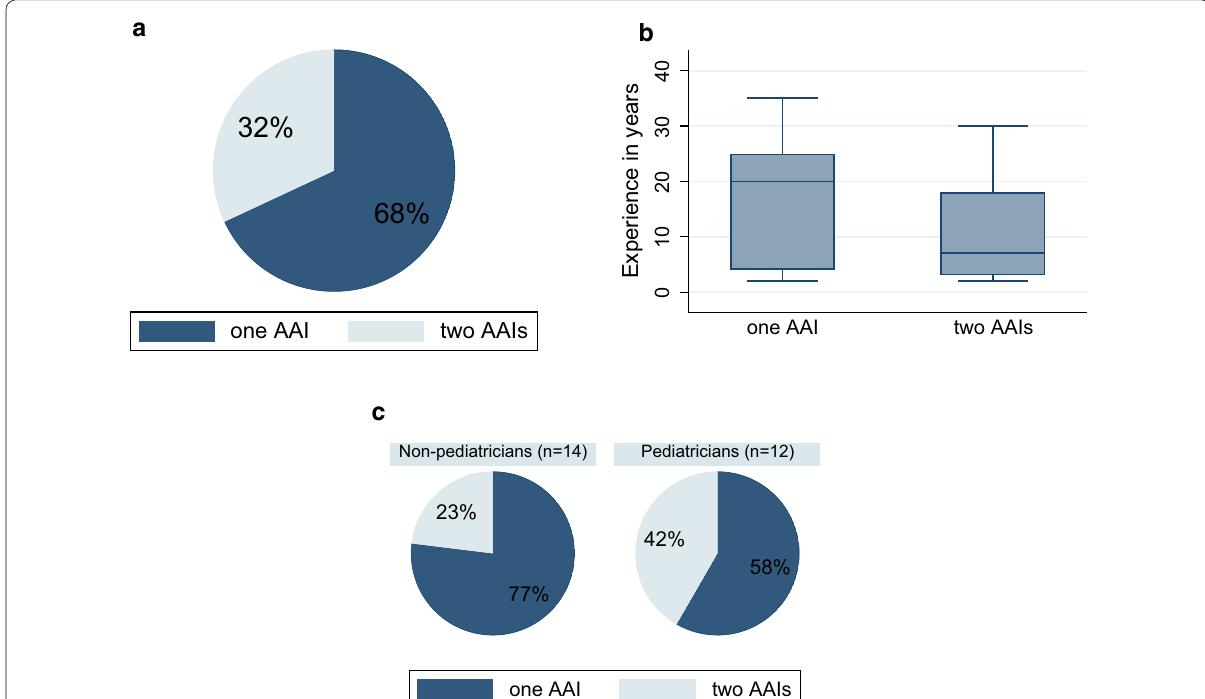
Fig. 2 Proportion of experts (n 26) who prescribe usually one or two adrenaline autoinjectors per one patient in total ( a ) and separate for = pediatricians and non‑pediatricians ( c ). The distribution of experience years in the field of anaphylaxis in the group of experts who usually prescribe one and in the group who usually prescribe two autoinjectors ( b